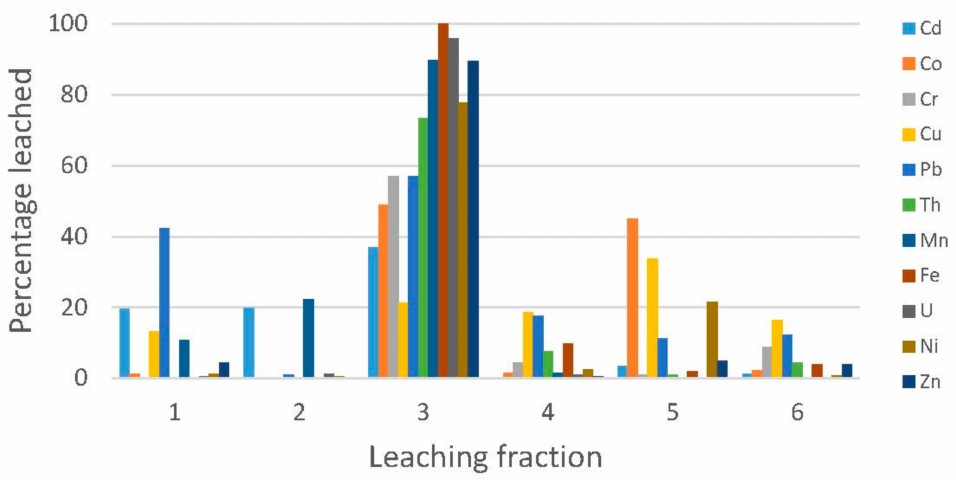
Figure 4. Release of metals from Talvivaara mine process waste in laboratory sequential leach tests.